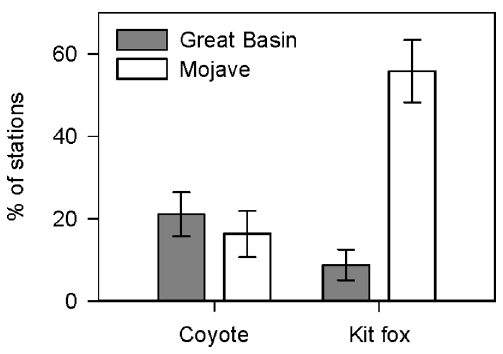
Figure 2. Overall proportions ( 6 SE) of scent stations visited by canids. Data were collected on coyotes ( Canis latrans ) and kit foxes ( Vulpes macrotis ) in the Great Basin and Mojave Deserts, USA, 2011 to